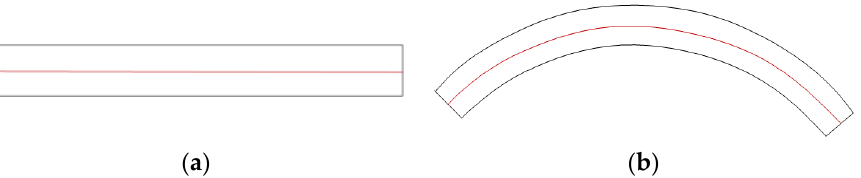
Figure 22. The generation of X-Z topological path for the straight ramp and the curved ramp: ( a ) straight ramp and ( b ) curved ramp.